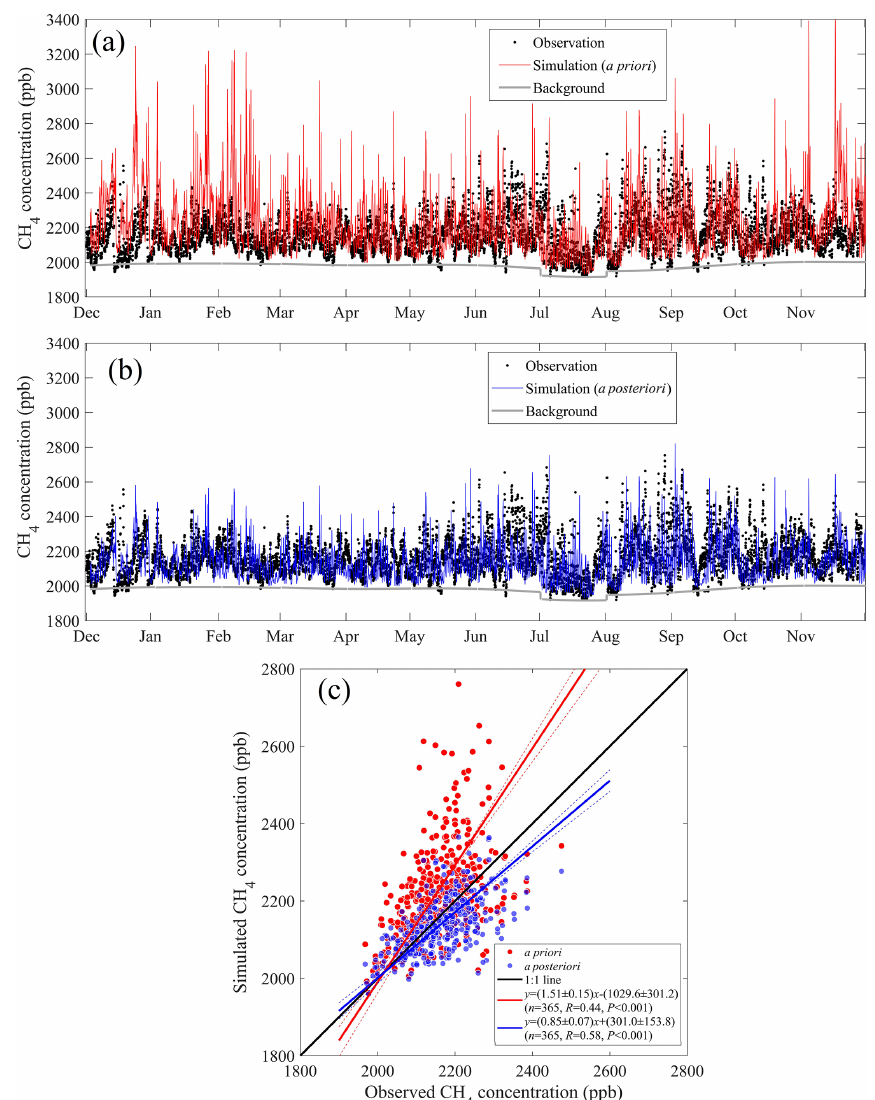
Figure 6. Comparisons of hourly CH 4 concentrations at the Hangzhou site between observations and simulations by using (a) a priori and (b) a posteriori emissions; (c) scatterplots of daily CH 4 averages by using a priori and a posteriori